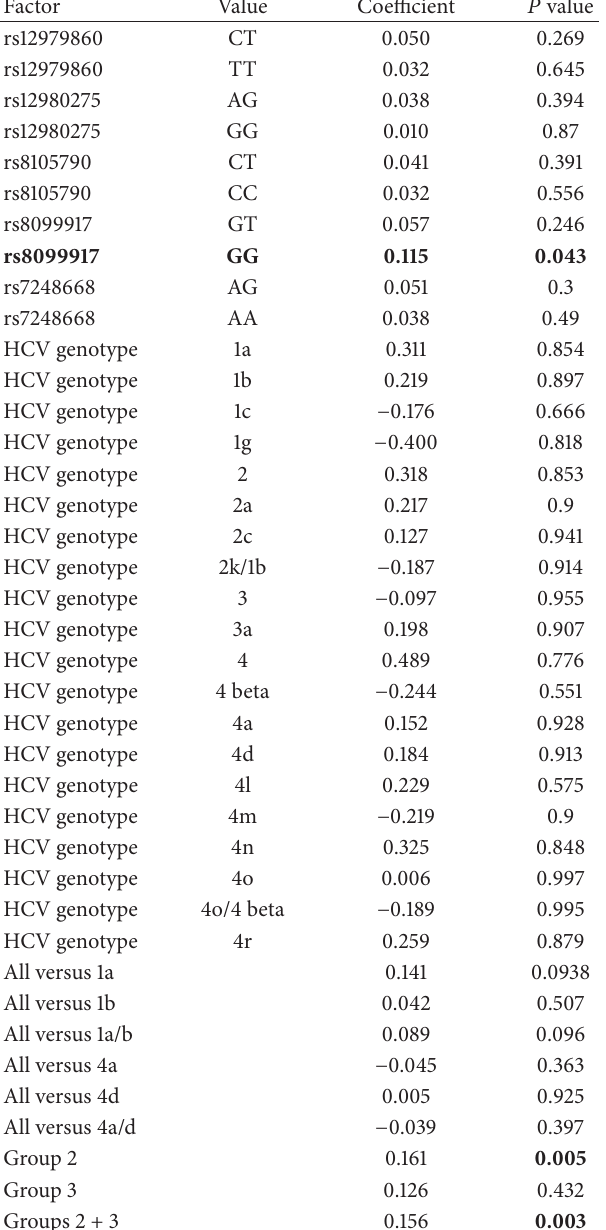
Table 8: Robust regression of serum IL28B levels with different factors.